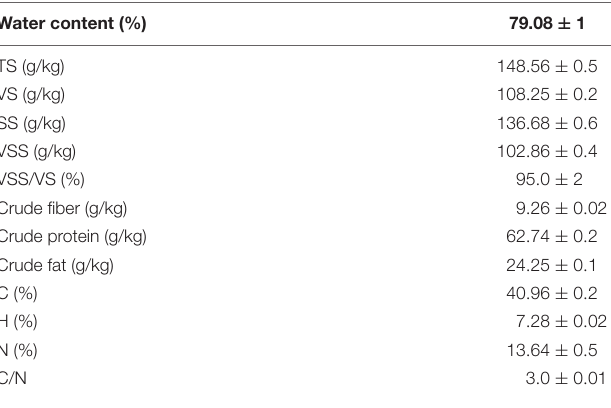
TABLE 1 | General properties of the sewage sludge used in